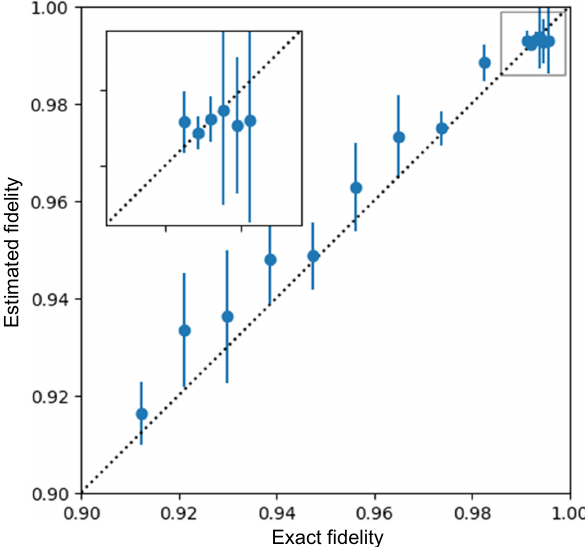
FIG. 8. The exact and estimated fidelity for a selection of ran- dom errors. Each estimate is based on data taken over 15 different lengths N . Each estimate is arrived at by applying a total of 300 000 unitary group elements. The diagonal line denotes the points where the exact and estimated fidelities are equal. The data agree with the line with a reduced χ 2 value of 1.0, indicating good